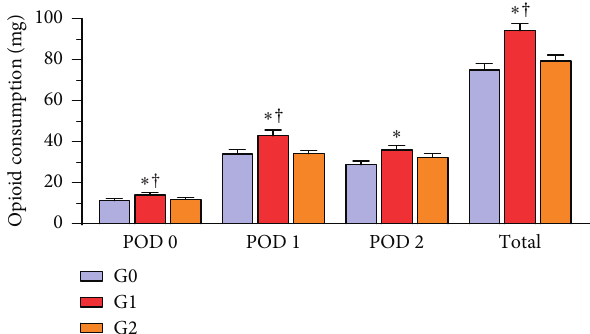
Figure 3: Comparison of opioid requirements between the three groups. ∗ P value < 0.05 compared with G0 † P value < 0.05 com- pared with G2. There were no significant differences between G0 and G2. Data were analyzed using one-way analysis of variance.